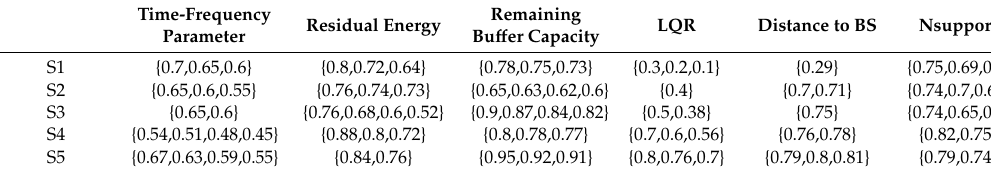
Table 4. Hesitant fuzzy decision matrix.